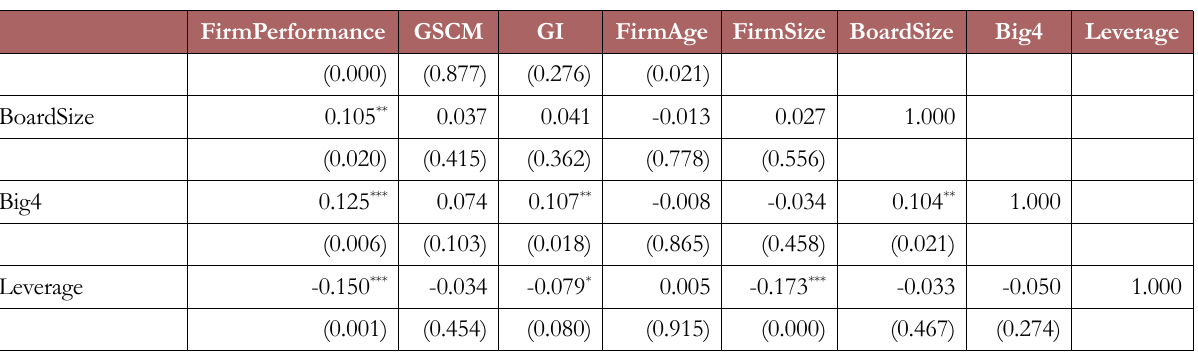
Table 2. Pearson